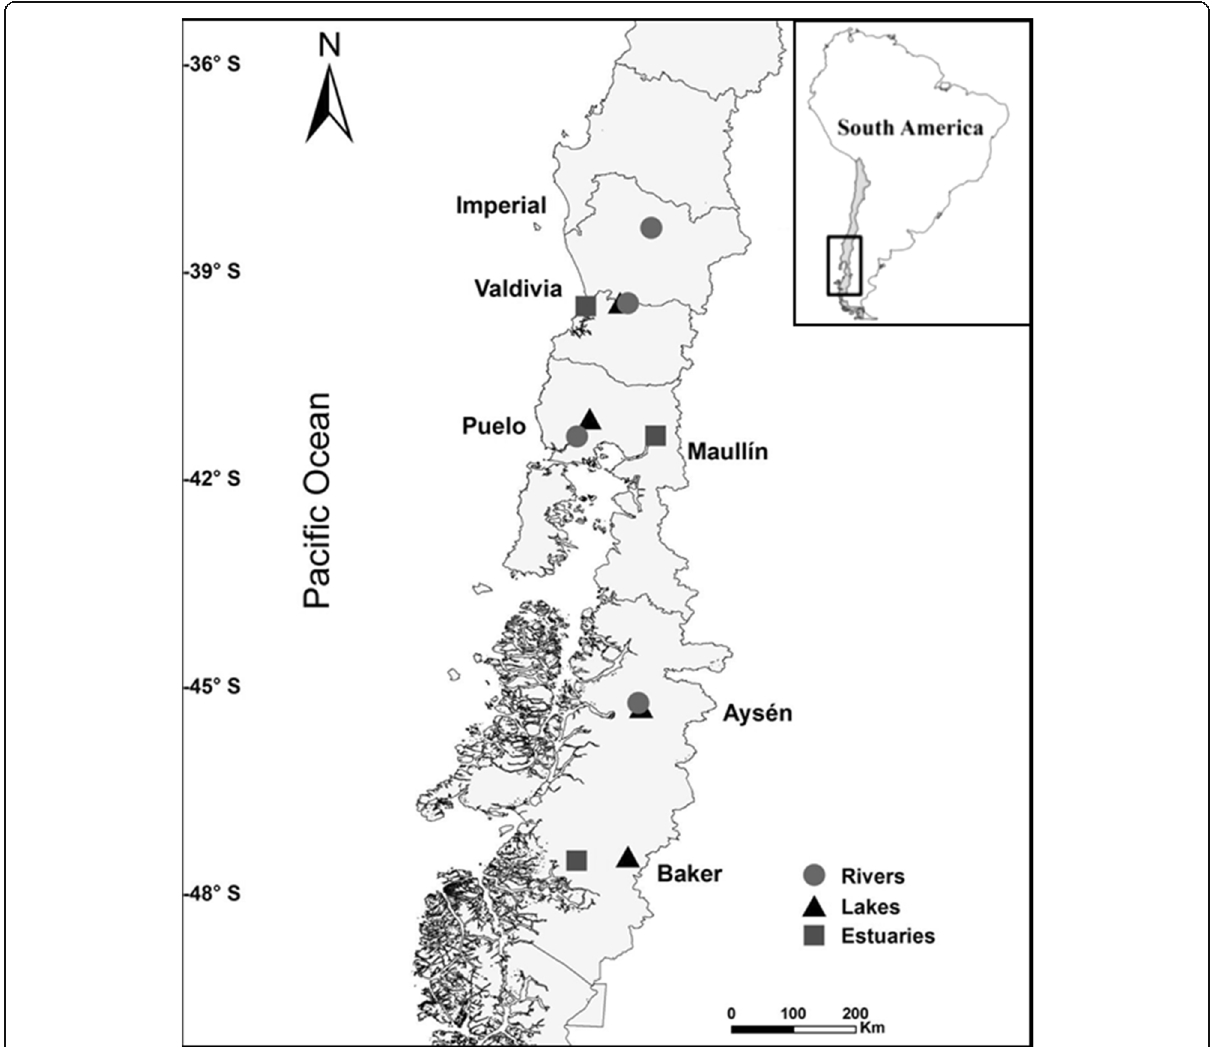
Fig. 1 The study area indicating fish sampling locations and ecosystems (rivers, lakes and